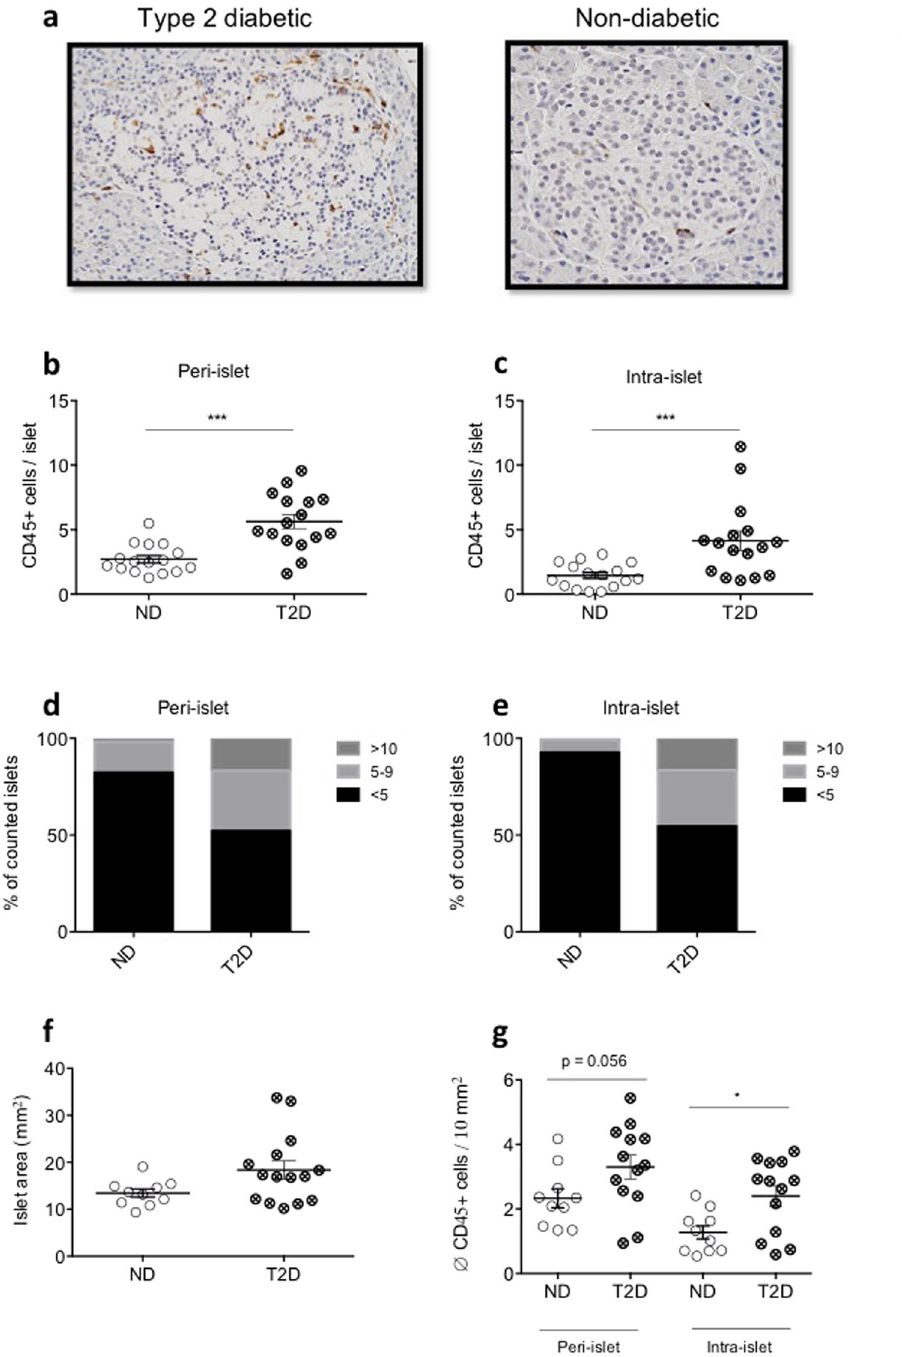
Figure 1. Pancreatic islets of patients with type 2 diabetes contain more CD45 + immune cells than islets of non-diabetic subjects. ( a ) Representative islet histology of type 2 diabetic (T2D) and non-diabetic (ND) subjects. Peri-islet and intra-islet CD45 + immune cell count ( b and c , respectively) and distribution ( d and e , respectively) in human pancreatic tissue sections of T2D and ND control subjects. Islet area ( f ) and islet-area- corrected average CD45 + immune cell count ( g ) in T2D and ND control subjects. ( b – e ) n = 17, 16 for T2D and ND subjects, respectively, ( f , g ) n = 14, 10 for T2D and ND subjects. n = 30–35 islets/subject were counted. *** P < 0.001. Statistical significance (P) was determined using the two-tailed Mann-Whitney U test. All error bars denote